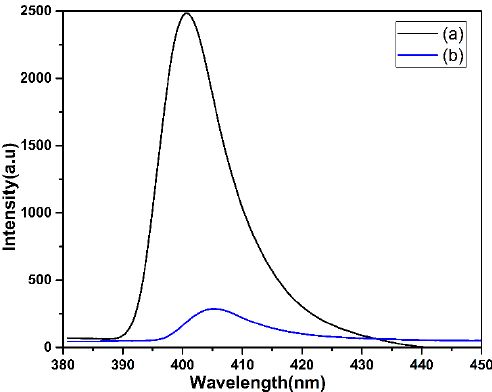
Figure 7. PL spectra of ( a ) HAP and ( b ) HAP − MnFe 2 O 4 nanocomposite.